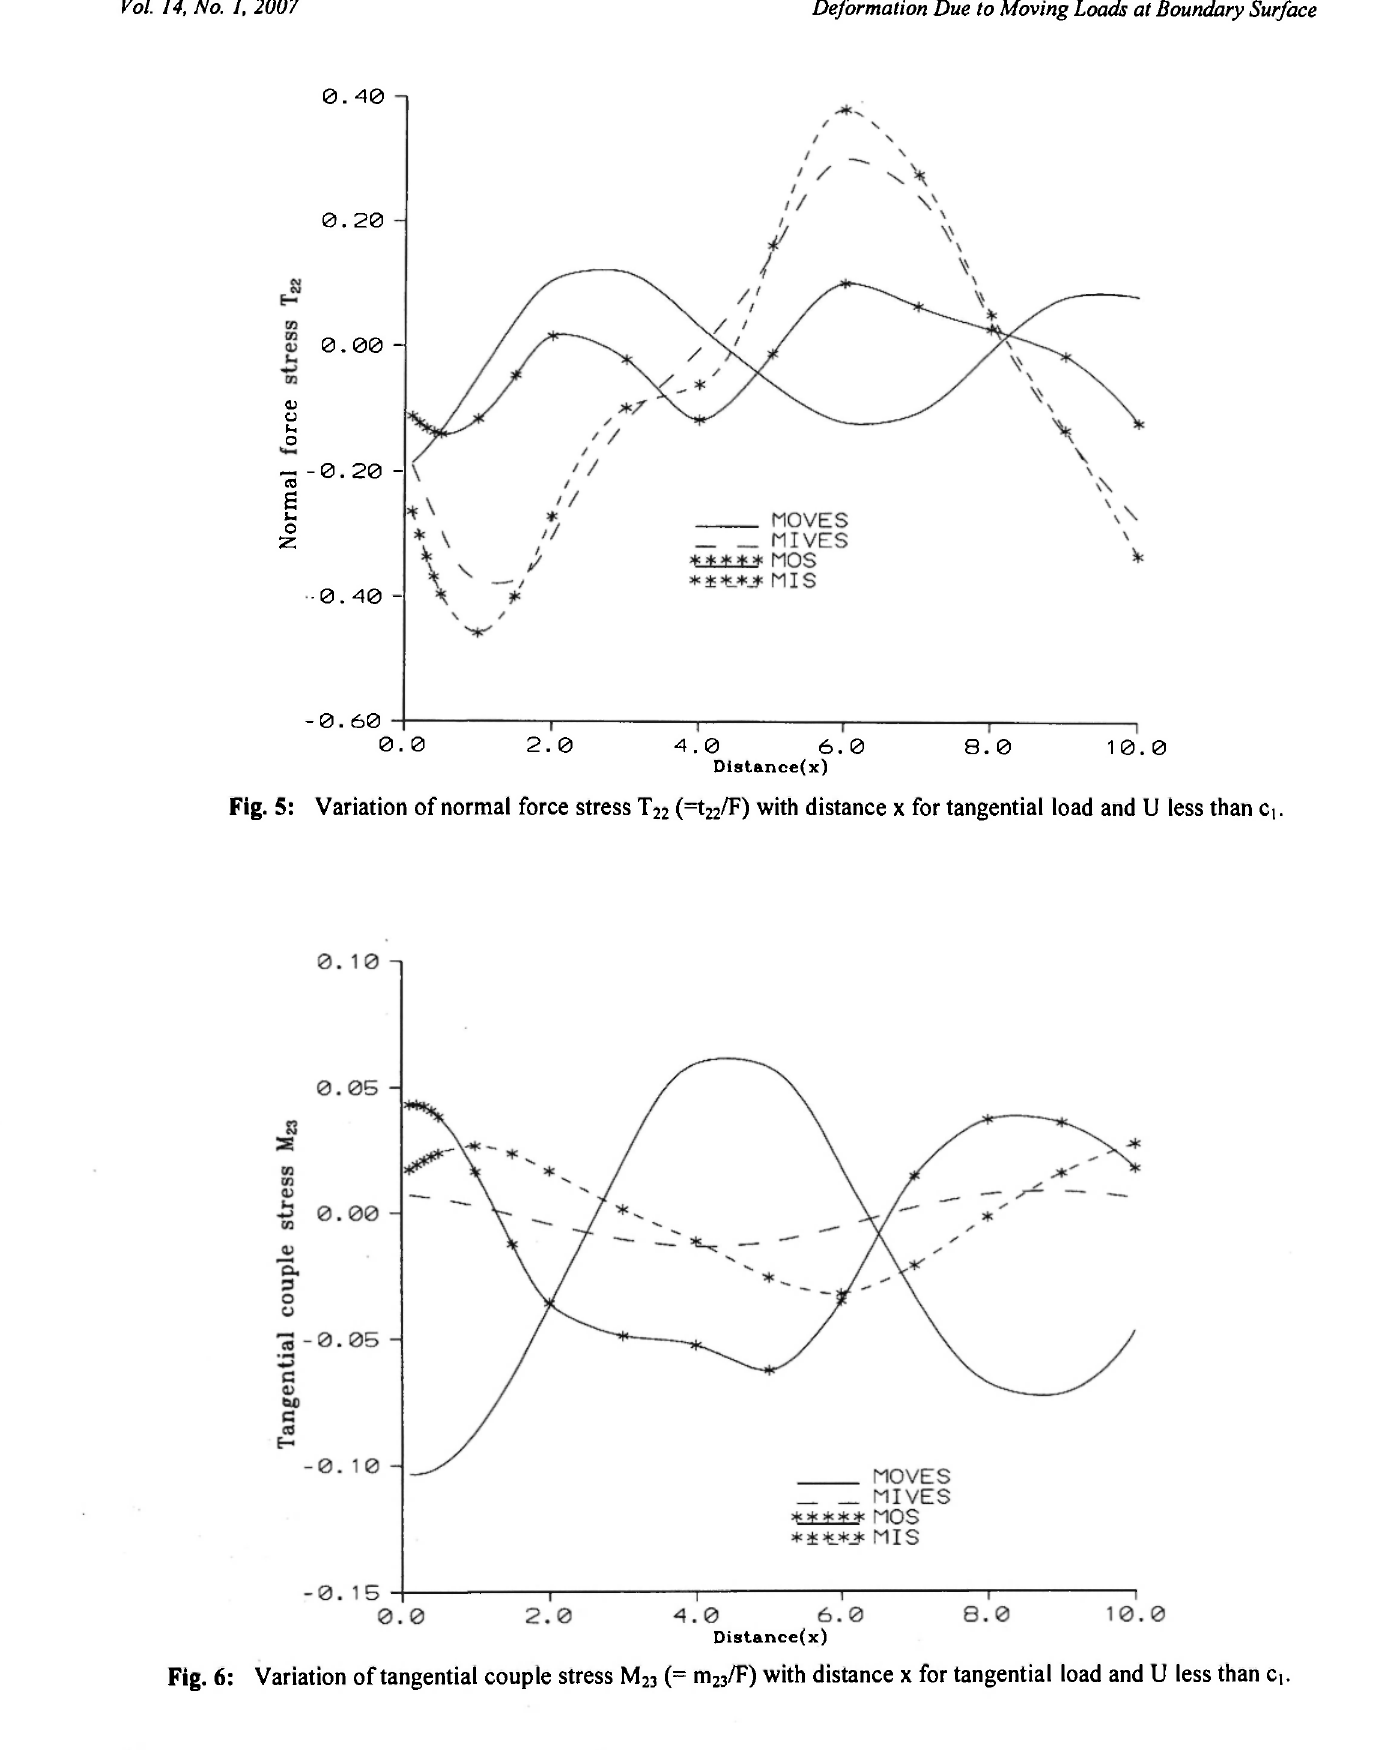
Fig. 5: Variation of normal force stress T 22 (=t 2 2/F) with distance χ for tangential load and U less than c,.